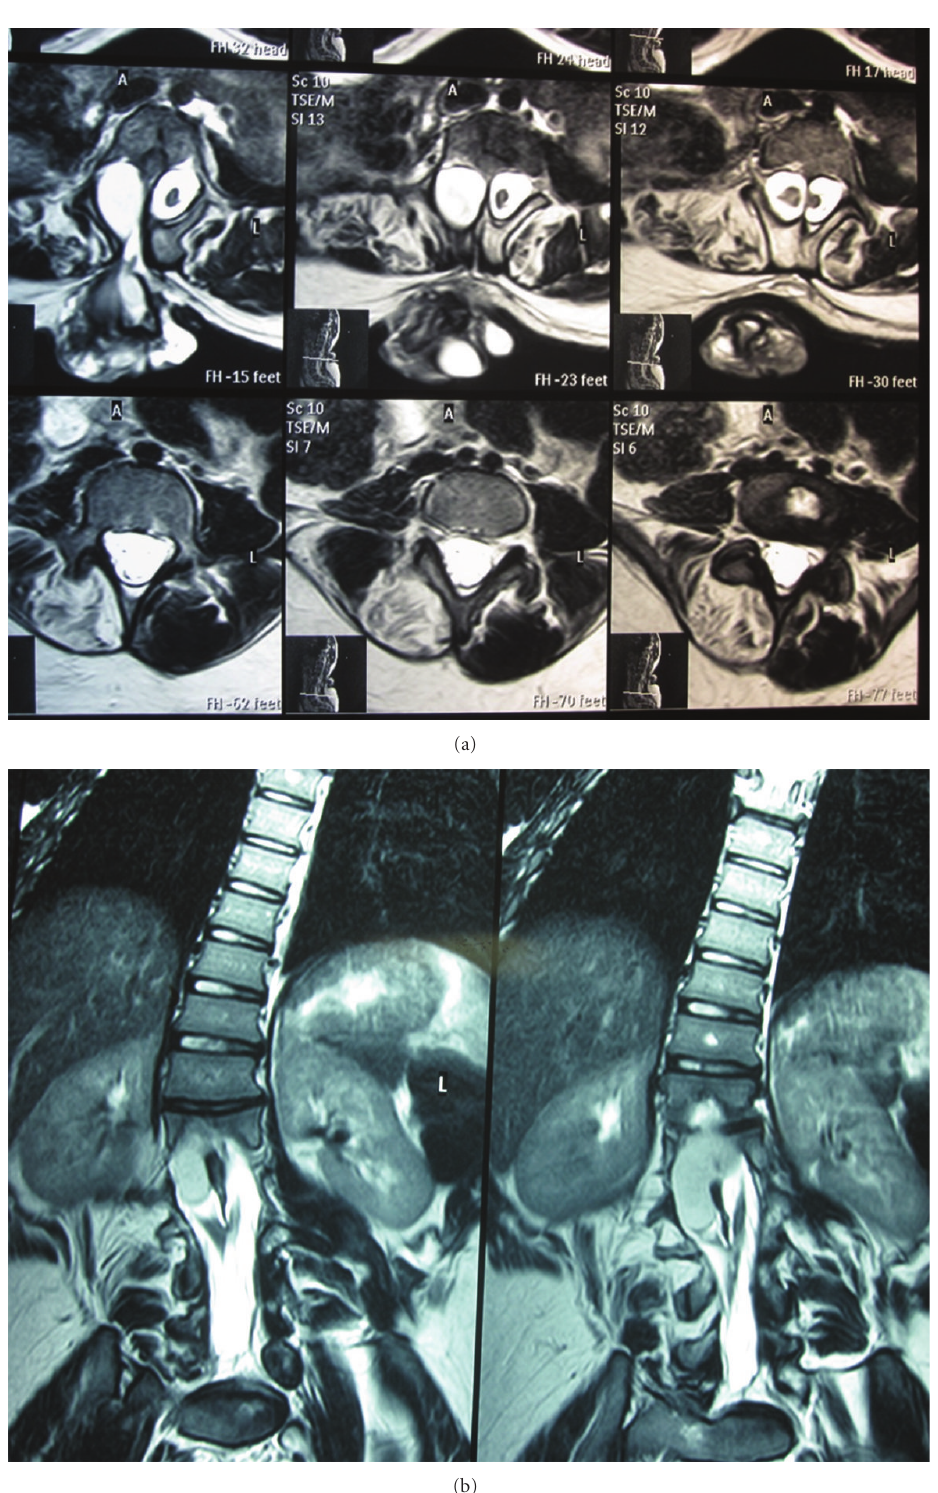
Figure 2: (a) Axial lumbar MRI T-2 images demonstrating a type 1 split cord malformation with the myelomeningocele attached to the right hemicord. (b) Coronal lumbar MRI T-2 images demonstrating a type 1 split cord malformation with a neurenteric cyst attached to the right